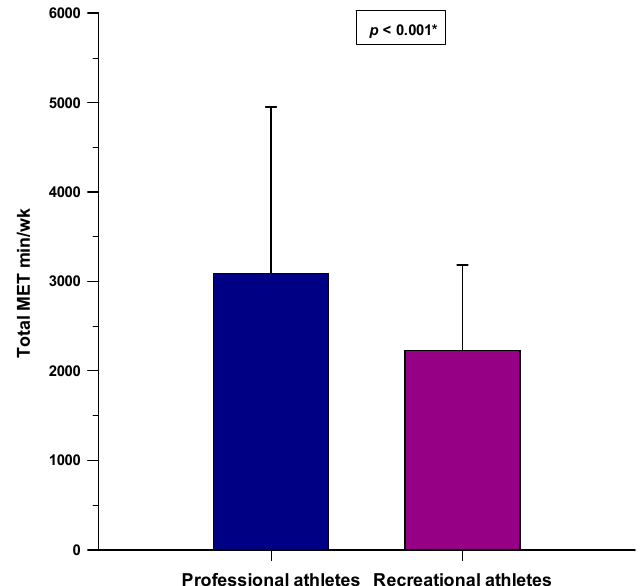
Figure 5. Difference in the total MET min/week score between the professional athlete ( N = 150) and recreational athlete groups ( N = 150). * Student’s t -test.